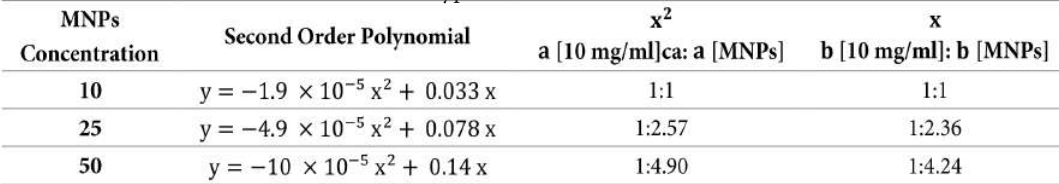
Table 3. Second order polynomial best-fit for normalized thermal profile of hyperthermia of